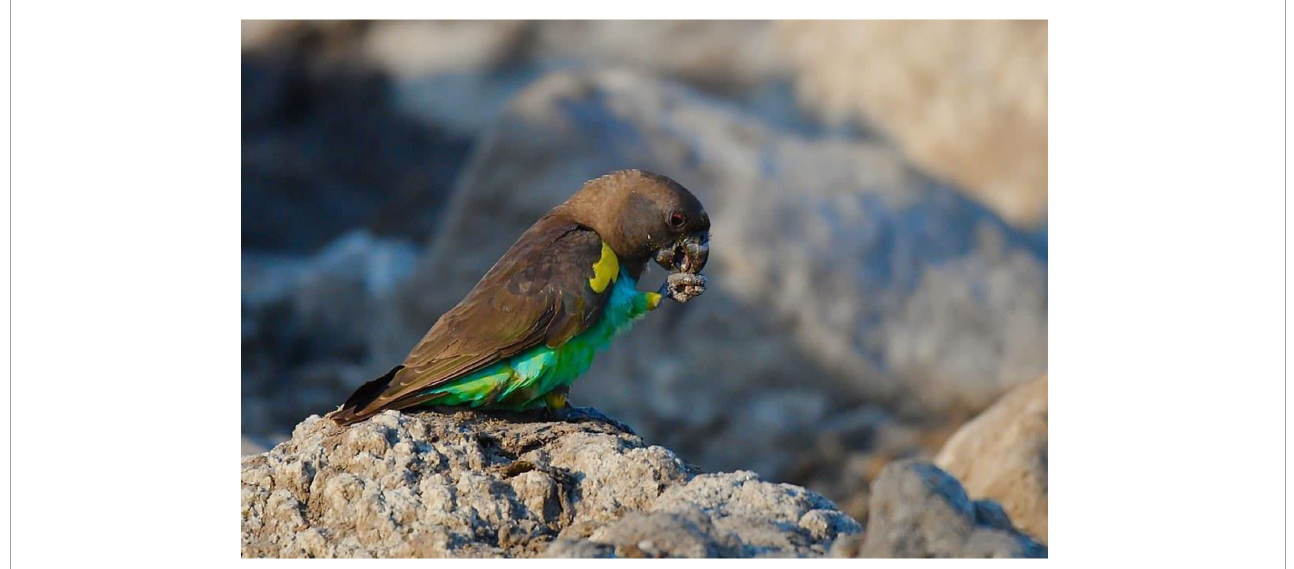
FIGURE4 Meyer’s parrot eating clay at a bird hide in Kafue National Park, Zambia. Credit: Butsfons. Source: https://www.flickr.com/photos/cirdan-travels/38709238452 (accessed 29.10.2022).